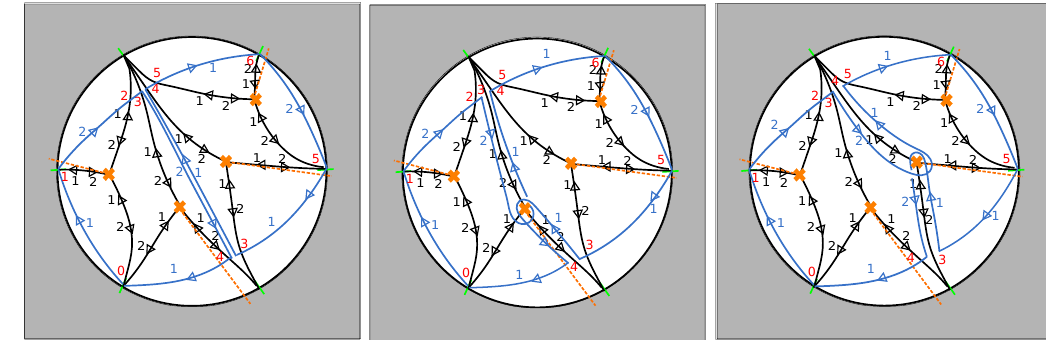
Figure 47 . The standard projection of three lifts e K 1 (left), e K 2 (middle) and e K 3 (right) whose contributions sum up to (cid:0) ( q + q (cid:0) 1 ) X (cid:13) . Here we have denoted the sheet numbers of lifted 1 (cid:0) (cid:13) 3 strands in